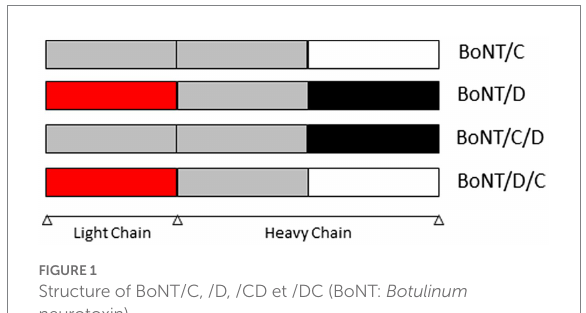
FIGURE 1 Structure of BoNT/C, /D, /CD et /DC (BoNT: Botulinum neurotoxin).